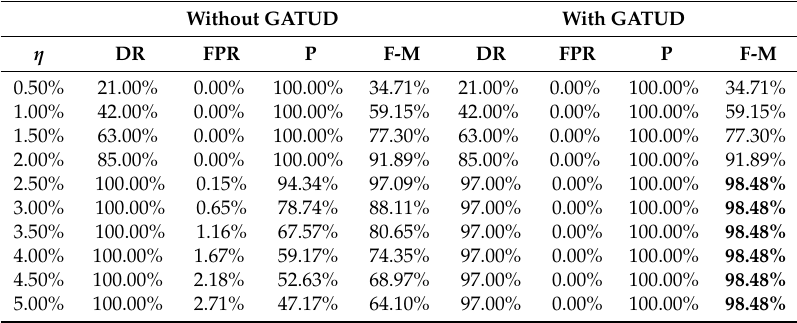
Table 8. The separation accuracy of abnormal observations with/without GATUD on MIRD. Without GATUD With GATUD